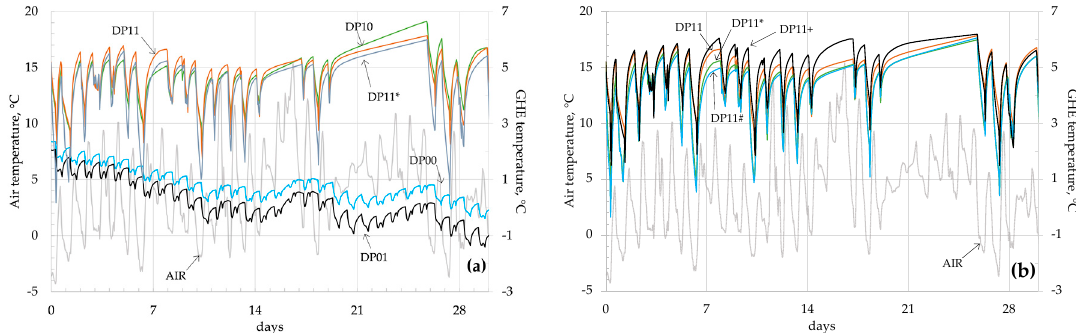
Figure 9. Details of winter temperatures ( a ) for cases DP00, DP01, DP10, DP11 and ( b ) DP11, DP11*, DP11#, DP11+.